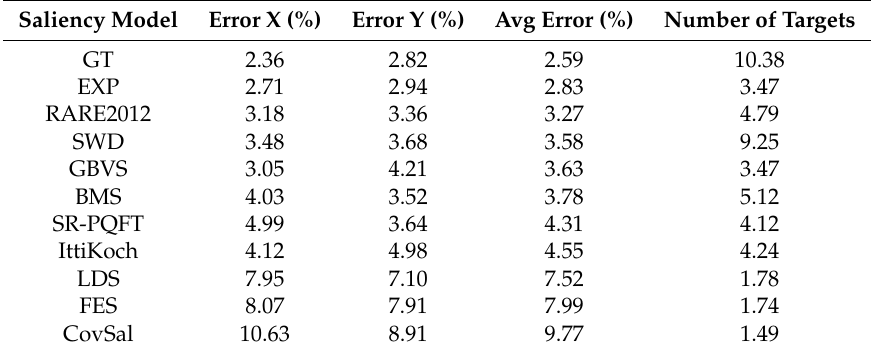
Table 3. Errors for various saliency models when MCF DIR is used. The last column shows the average number of targets per image found for the given saliency model.